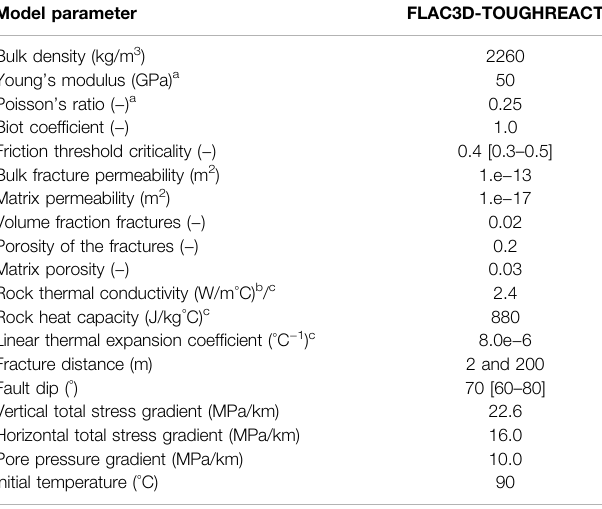
TABLE 1 | Model parameters and model ranges for FLAC3D-TOUGHREACT. Values between square brackets indicate a stochastic range of input parameters (uniform distribution).